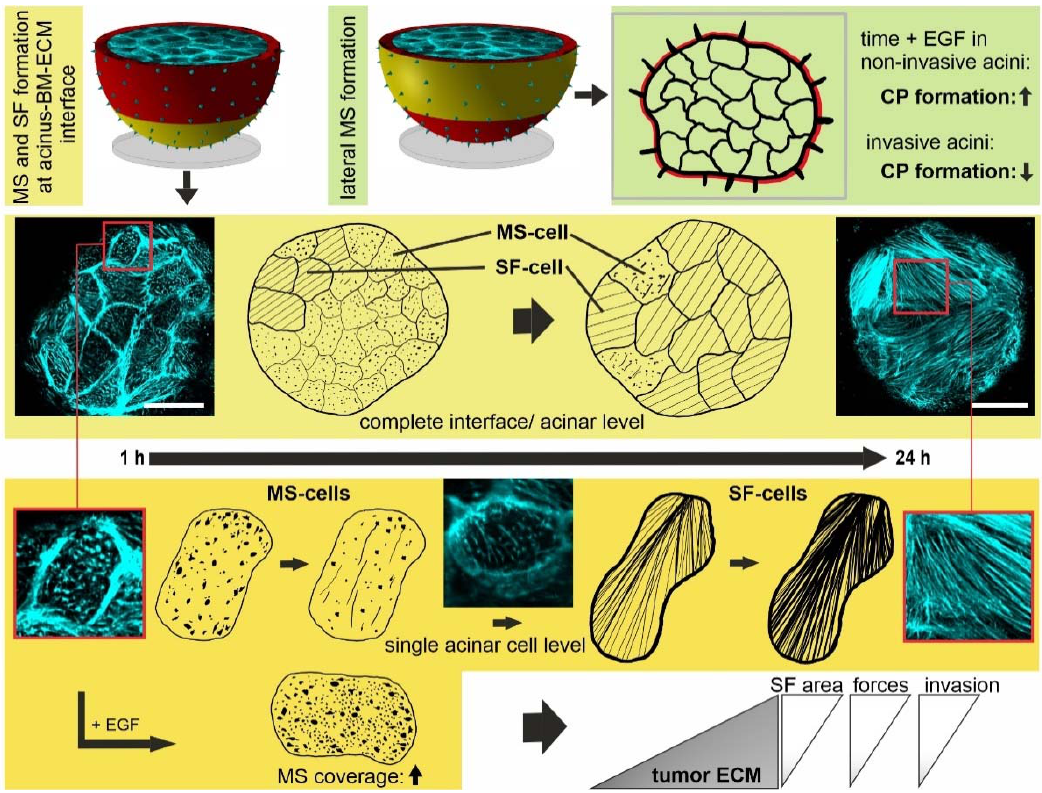
Figure 8. Graphical summary. A mechanistic model for the dynamic switch from non-proteolytic BM-traversing actin protrusions (CP) to highly contractile ventral stress fibers during the invasive transition of benign breast acini. Under non-invasive conditions and at the early stages of BM invasion, CPs act as mechanical probing units at the acinus–BM–ECM interface. In the course of the invasive transition, actin cytoskeleton remodeling mediates the switch from MS cells (rich in microspikes) to SF cells (rich in stress fibers). Oncogenic EGF and tumor-like ECM stiffness fuel this process. Progressively reinforced SF cells generate local hot spots of high contractile forces at the BM–ECM interface. This stress weakens the BM barrier chronically. The invasive transition of initially benign breast cells converges into BM disruption and finally cell invasion into the microenvironment. Supplementary Materials: The following are available online at www.mdpi.com/xxx/s1, Figure S1: The radii of breast acini depend on maturation state and EGF treatment, Figure S2: Invadopodia marker protein localization in single migrating cells and MCF10A acini, Figure S3: Focal adhesion and pMLCK localization in migrating MCF10-A cells, Figure S4: Traction force microscopy and hot spot segmentation, Movie S1: Lateral MS formation (Example 1), Movie S2: Lateral MS formation (Example 2), Movie S3: Lateral MS formation (Example 3), Movie S4: Migrating MCF10A cells, Movie S5: Movement of MCF10A acini on a tumor-like substrate (12 kPa), Movie S6: Stress fiber formation at the cell–BM–ECM interface (Example 1), Movie S7: Stress fiber formation at the cell- BM-ECM interface (Example 2). Author Contributions: Conceptualization, E.N., J.E., R.M., B.H.; Supervision, E.N., B.H., R.M.; funding acquisition, R.M., E.N.; methodology, J.E., G.D., R.S.; formal analysis, J.E., G.D., R.S.; visualization, J.E., J.K.; writing—original draft, J.E.; writing—review & editing, E.N., B.H., R.M. All authors have read and agreed to the published version of the manuscript. Funding: Funded by the Deutsche Forschungsgesellschaft (DFG, German Research Foundation)- 363055819/GRK2415, through SPP1782 within the projects H02384/2 and ME1458/8. Institutional Review Board Statement: Not applicable. Informed Consent Statement: Not applicable.